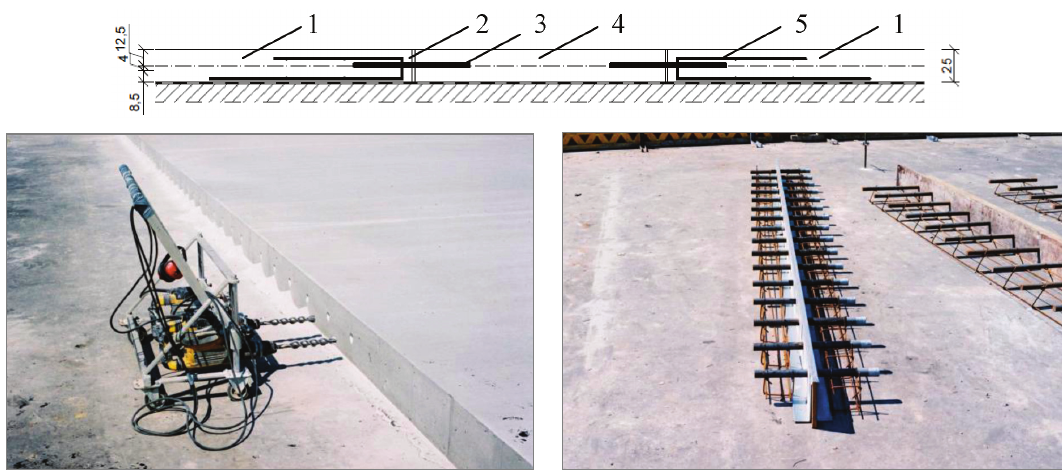
Fig. 4. Detail of dowelled slab connection and a drill for openings, as well as prefabricated joint elements with dowels [own study, photo by A.